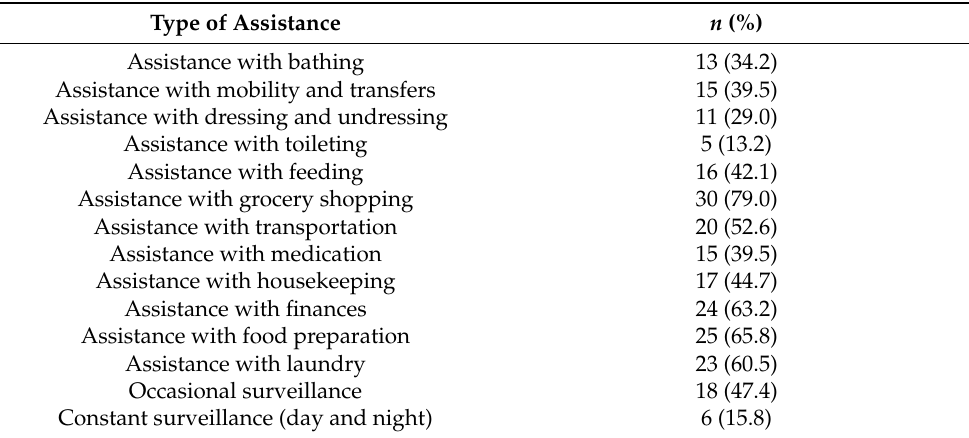
Table 2. The type of assistance provided by family caregivers before their older relative’s hospitalisa- tion ( n = 38).